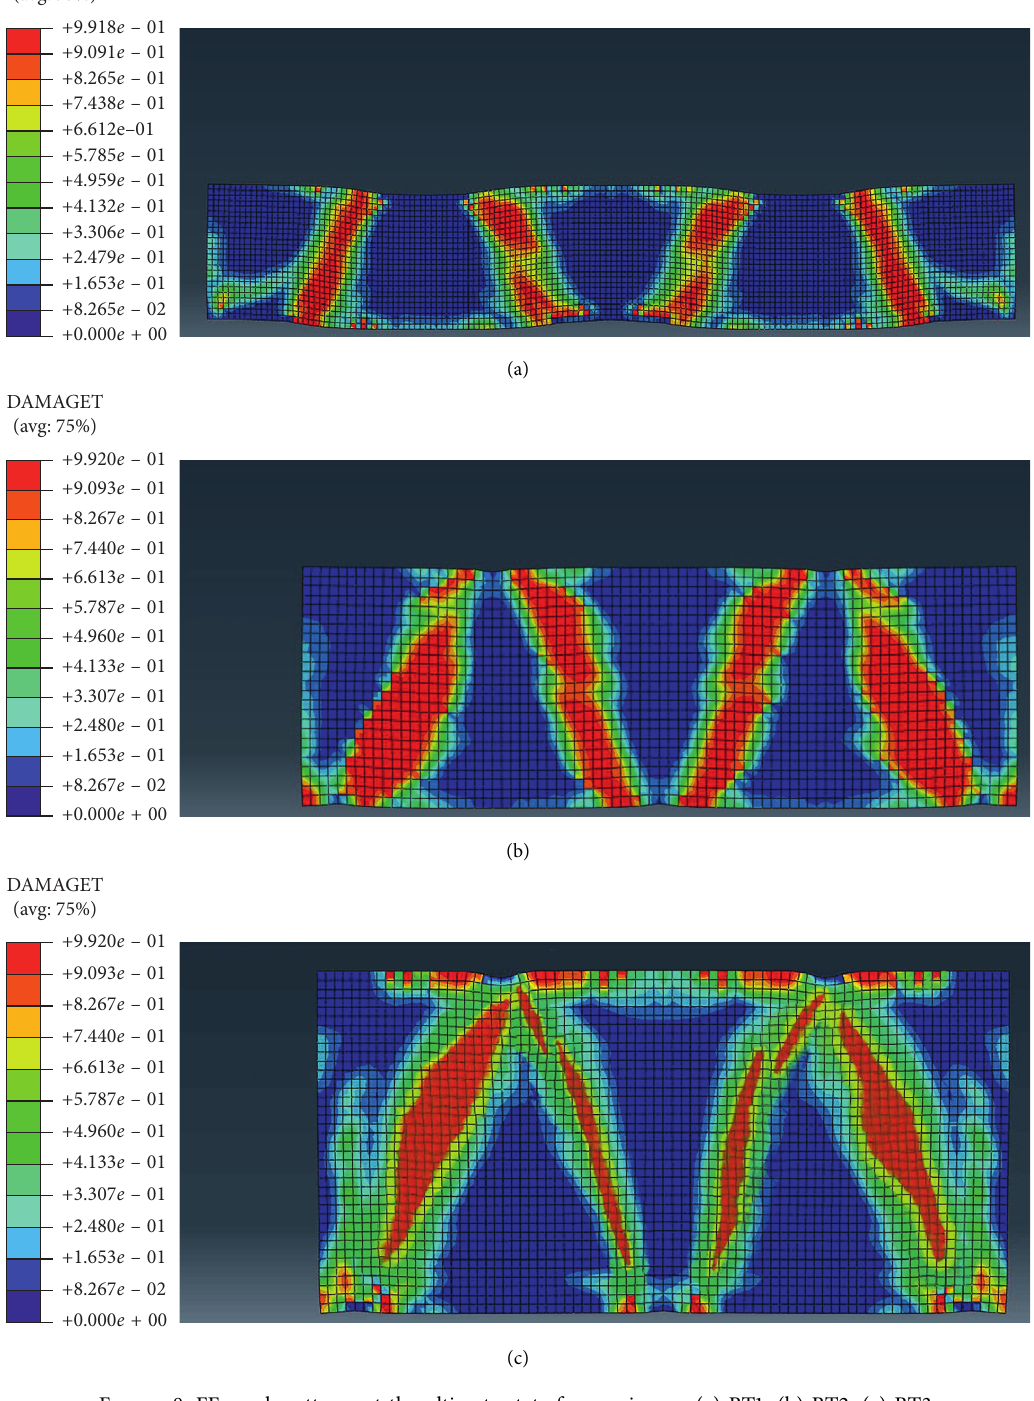
Figure 8: FE crack patterns at the ultimate state for specimens. (a) BT1. (b) BT2. (c)